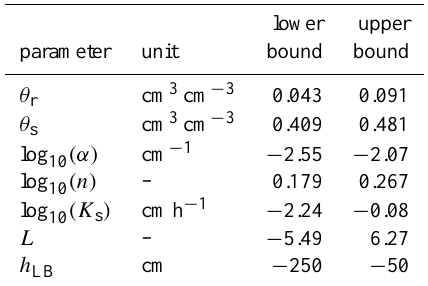
Table 1. Lower and upper bounds of the estimated